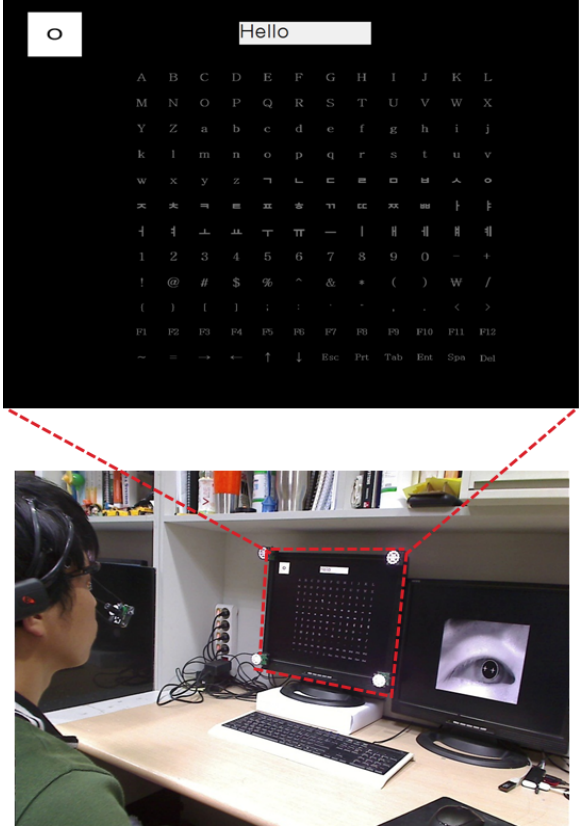
Figure 12. Example of the text typing system of a desktop computer using the proposed